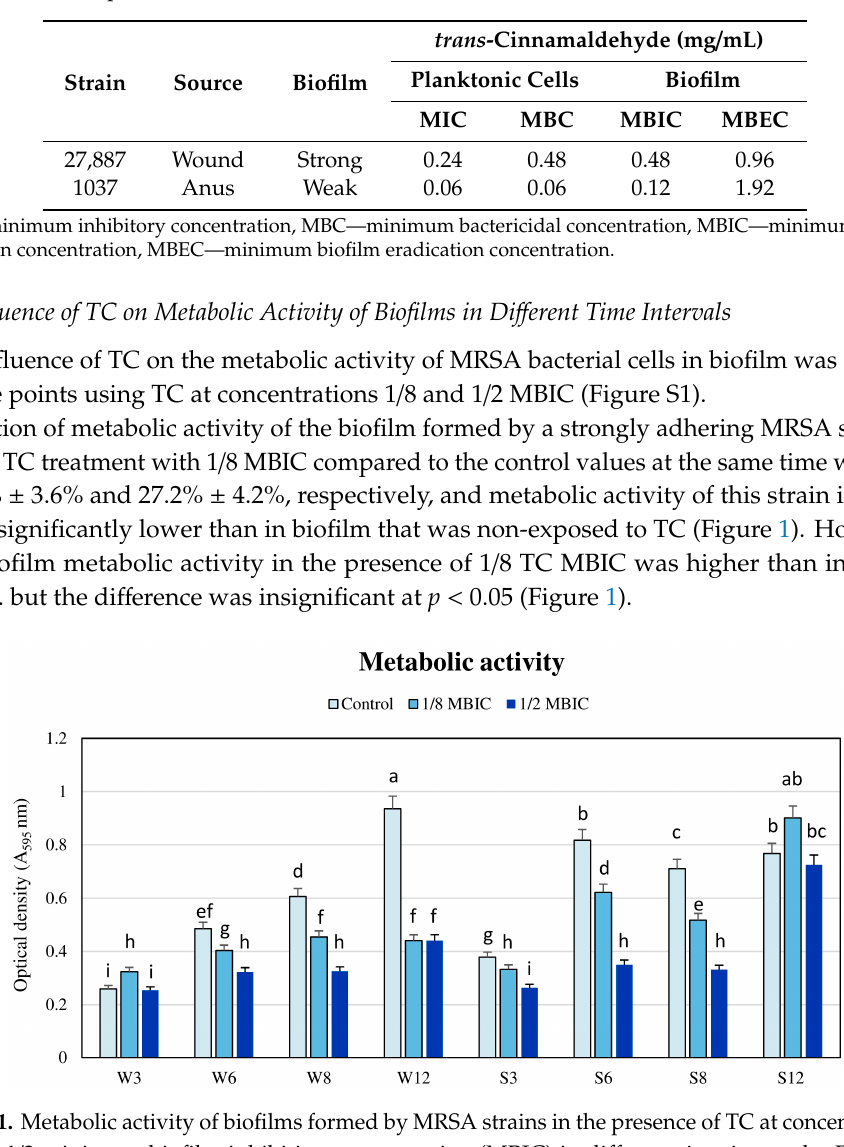
Table 1. Susceptibility to trans -cinnamaldehyde (TC) of methicillin-resistant Staphylococcus aureus (MRSA) strains in planktonic culture and biofilm conditions.